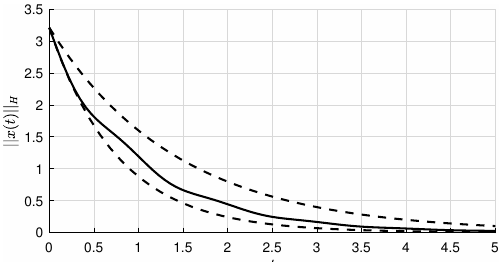
Figure 1. Solution of the linear time-invariant system from Example 1 and 2 with an initial state x ( 0 ) = ( x 1 ( 0 ) , x 2 ( 0 )) T = ( − 4,3 ) T (the solid line) and the lower and upper bound given by (8) (the dashed